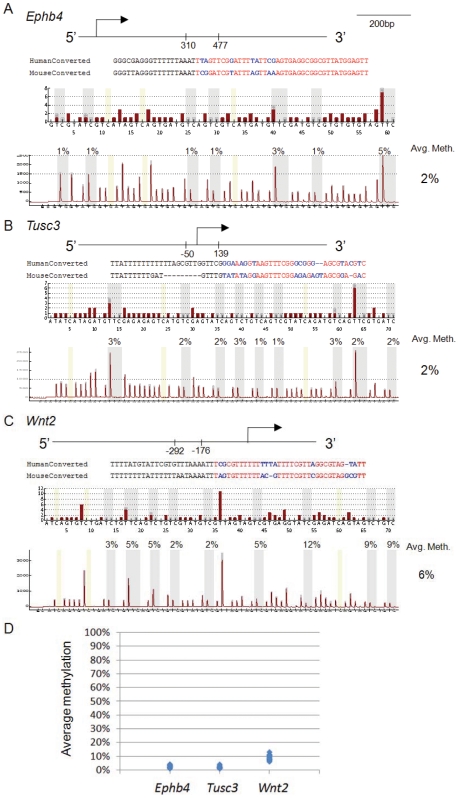
DNA methylation status of MAP conserved regions in mouse.Schematic of (A) Ephb4 locus (310 to 477 relative to the transcriptional start site according to NM_010144), (B) Tusc3 locus (−50 to 139 relative to the transcriptional start site according to NM_030254) and (C) Wnt2 locus (−292 to −176 relative to the transcriptional start site according to NM_003391), showing the regions investigated by bisulfite pyrosequencing. Sequence alignments on bisulfite converted DNA between human and mouse at the first 60 nucleotides including the sequencing primers are shown. Sequences highlighted in red are the nucleotides being investigated while the nucleotides highlighted in blue are the differences between them. Reference pyrograms are provided and one representative sample for each locus is shown. (D) Summary of methylation level at Ephb4, Tusc3 and Wnt2 in 21 outbred mice. No “on-or-off” methylation variation is found in the mouse conserved regions.